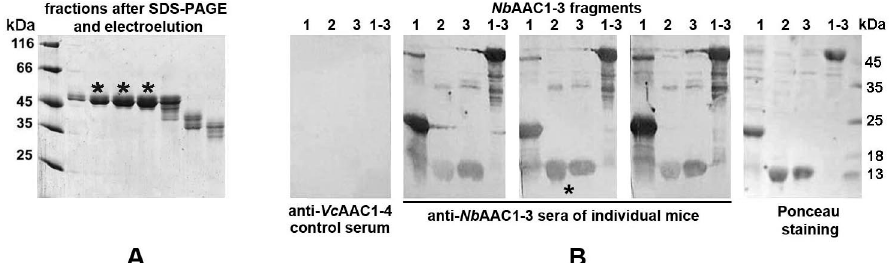
Figure 1. ( A ) Nb AAC1-3 chimeric protein carrying the outer loops of three N. bombycis ATP/ADP transporters was overexpressed in E. coli , purified by SDS-PAGE and gel electroelution. The pure protein fractions, marked with asterisks, were dialyzed and used to immunize mice. ( B ) Western blot analysis of immune sera from individual mice allowed us to select a mouse whose serum showed similar levels of Abs to the loops of all three N. bombycis transporters (marked with an asterisk) and use it to construct the scFv library. As a negative control, we used the serum of a mouse immunized with the chimeric Vc AAC1-4 protein carrying the outer loops of the microsporidium Vairimorpha ceranae four ATP/ADP transporters [21] also overexpressed in E. coli and